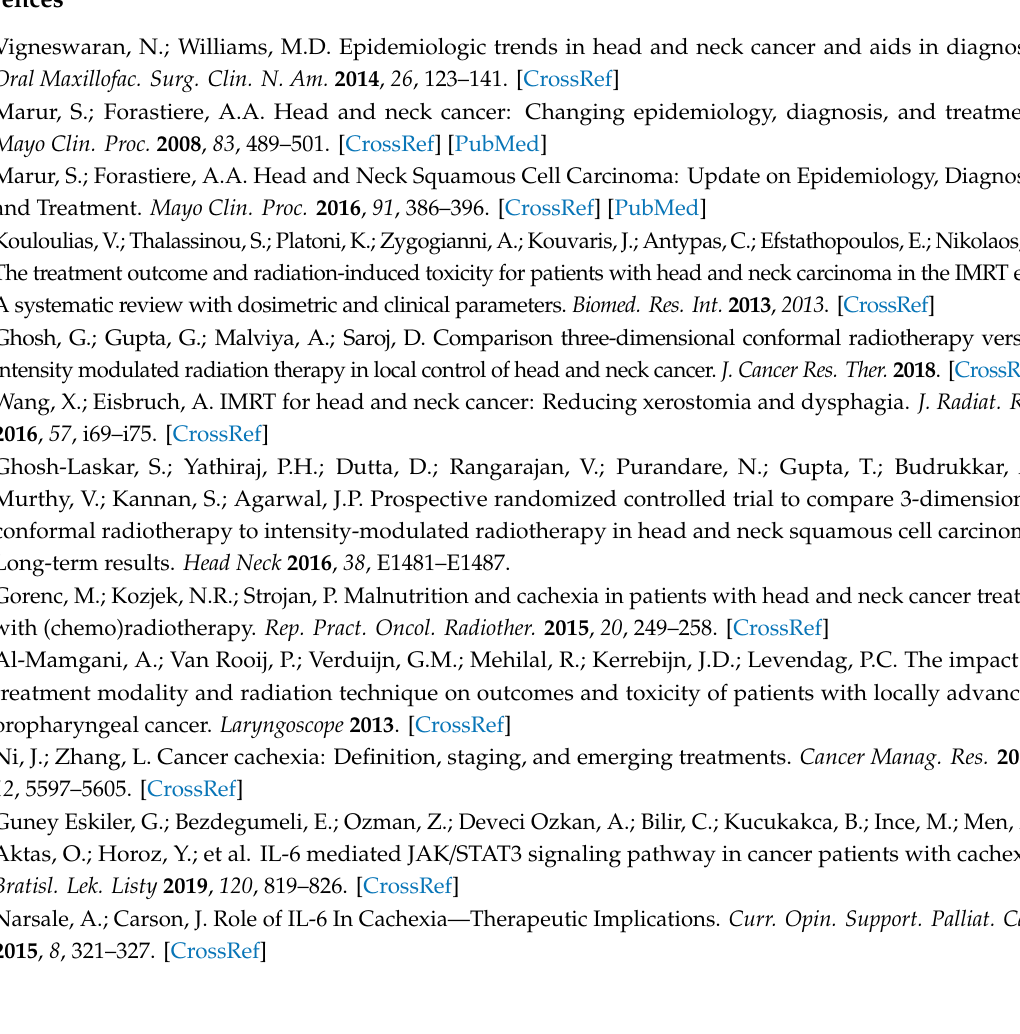
Table S1. Distribution of demographic, clinical and nutritional variable saccording to ITGAM genotypes. Table S2. Distribution of demographic, clinical and nutritional variables according to SGA. Table S3. Distribution of demographic, clinical and nutritional variables according to NRS and